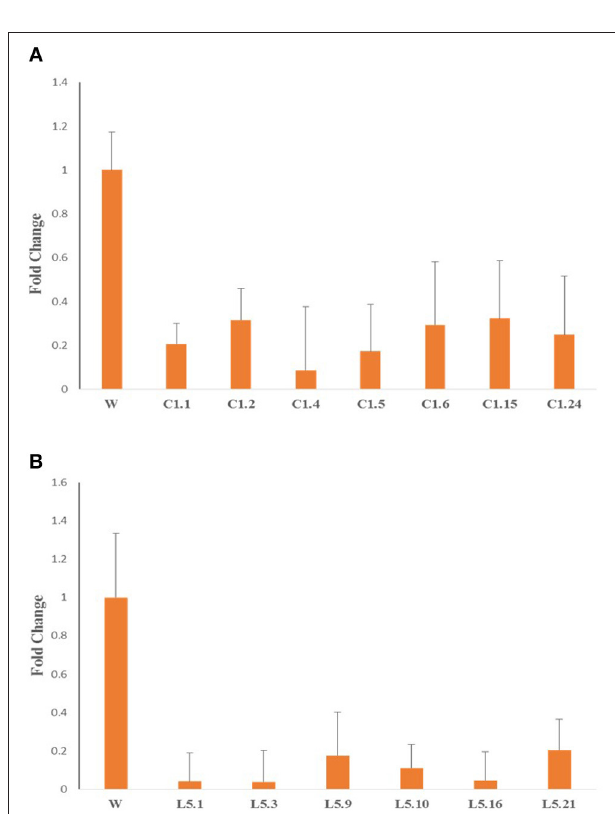
FIGURE 10 | Expression of target genes (A) Mi-col-1 , and (B) Lemmi-5 in adult females isolated from respective transgenic tomato lines 35 days post